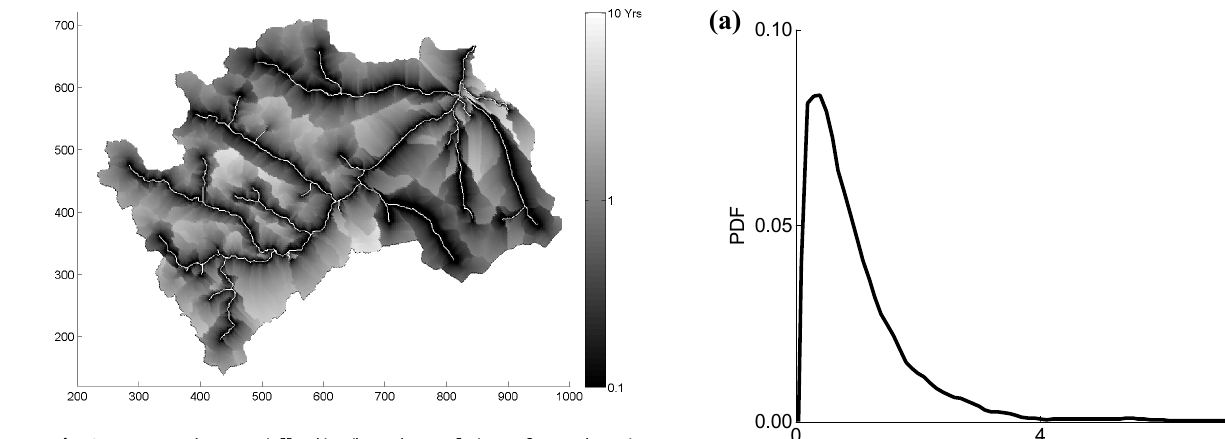
Fig. 3. Present day spatially distributed travel times for each point in the Abiskojokken catchment through the subsurface landscape to the stream network. Note that the color bar has a log scale to show the variability in the spatial distribution. The axes for the map of spatially distributed travel times are labeled in kilometers of linear distance.